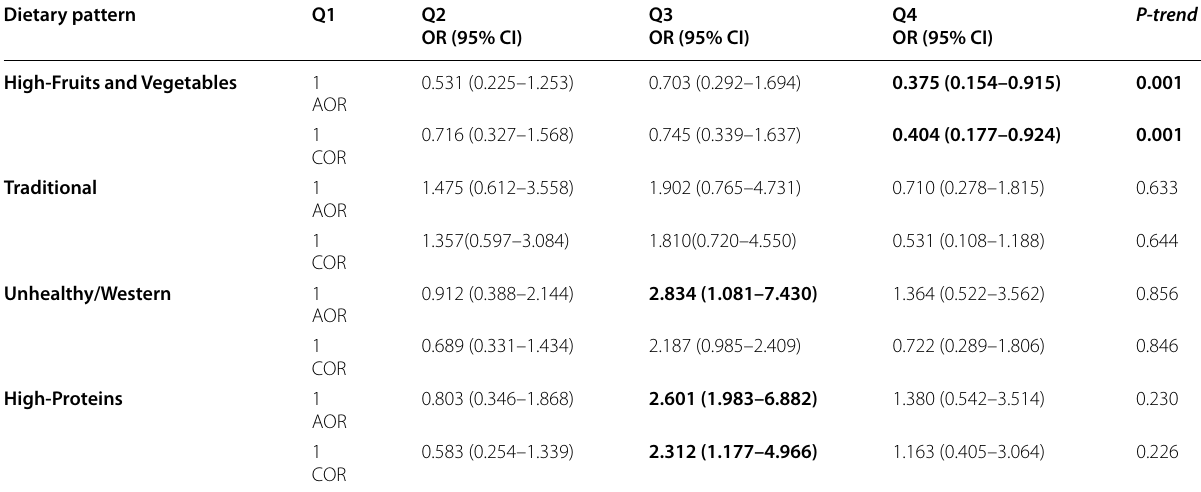
Adjusted for age, BMI, physical activity level, total energy intake, number of pregnancies and lactation, health problems, smoking, education level, marital status, and history of osteoporosis The Control group was considered the reference group for dietary pattern analysis AOR, COR and CI Adjusted odds ratio, crude odds ratio and confidence interval Odd ratios are considered statistically significant at P ≤